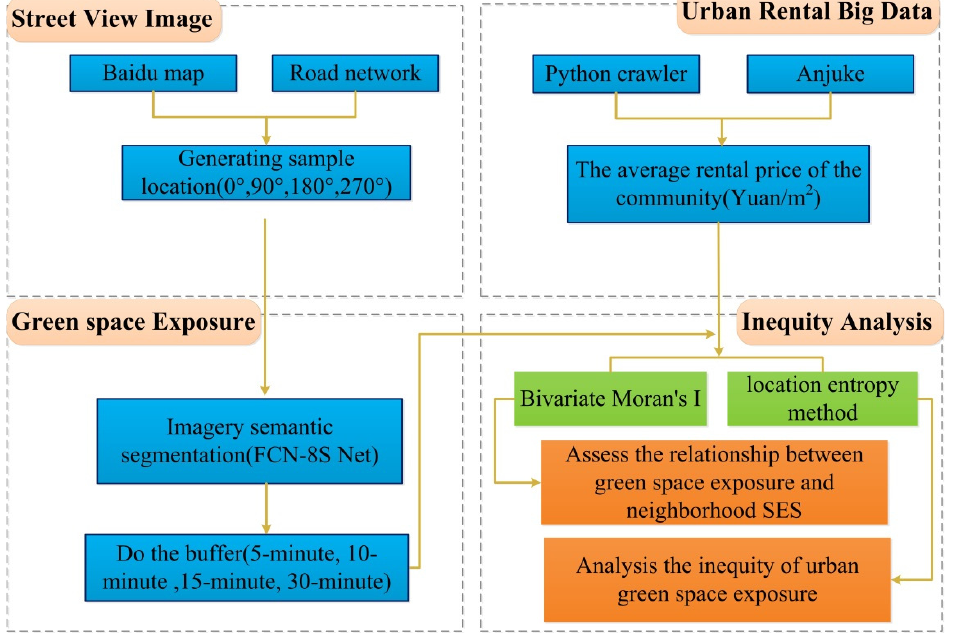
Figure 2. Green space exposure inequity assessment framework. Note: the blue represents input data; the green represents methods; the orange represents outputs.